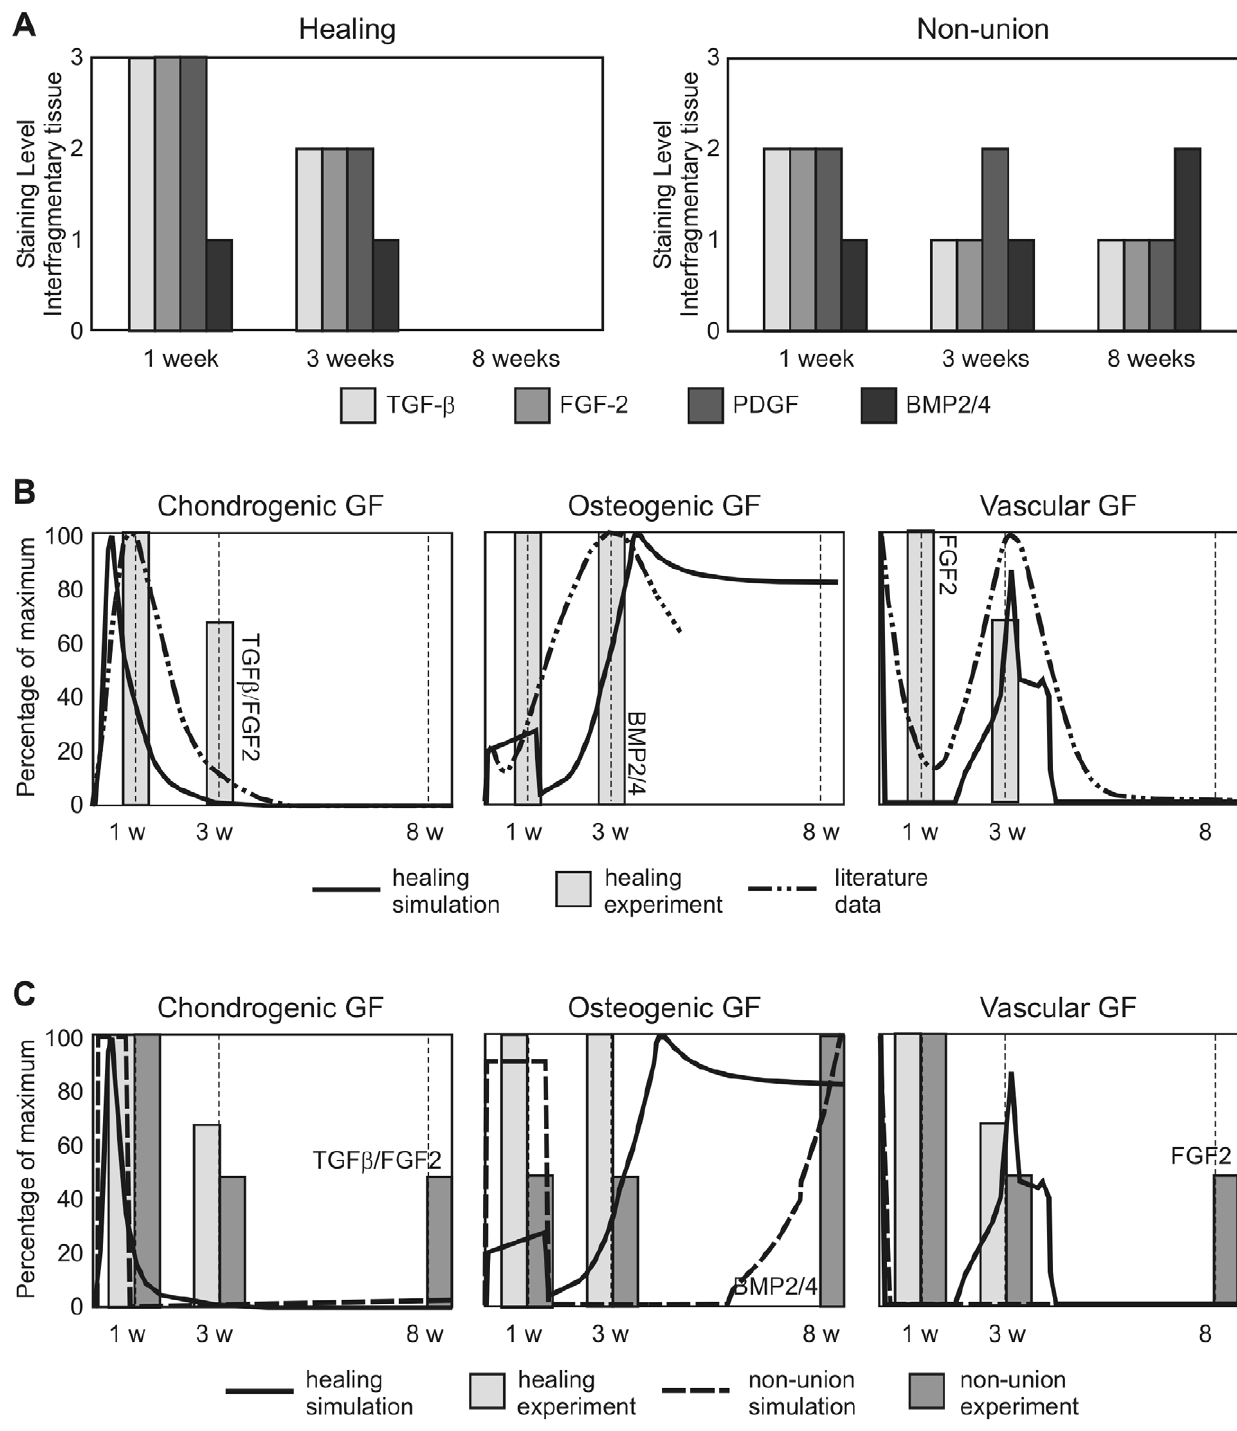
Figure 4. Growth factor expression in healing and non-union groups. ( A ) A comparison of growth factor staining index (based on immunohistochemical analysis) within the interfragmentary gap at 1, 3, 8 and 16 weeks post-osteotomy between healing and non-union groups. ( B ) Relative variation of the density of the generic osteogenic, chondrogenic and vascular growth factor density as calculated by the mathematical model for the healing group (full line) and reported in literature (dash-dotted line) [21–23]. Bars represent the experimentally measured growth factor levels of the growth factors belonging to these functional families (according to [21–23]) for the normal healing group. ( C ) Relative variation of the density of the generic osteogenic, chondrogenic and vascular growth factor density, as calculated by the mathematical model for healing and non-union set- ups. Experimentally measured (bars) growth factor variations of growth factors belonging to these functional families (according to [21–23]) are depicted as well.